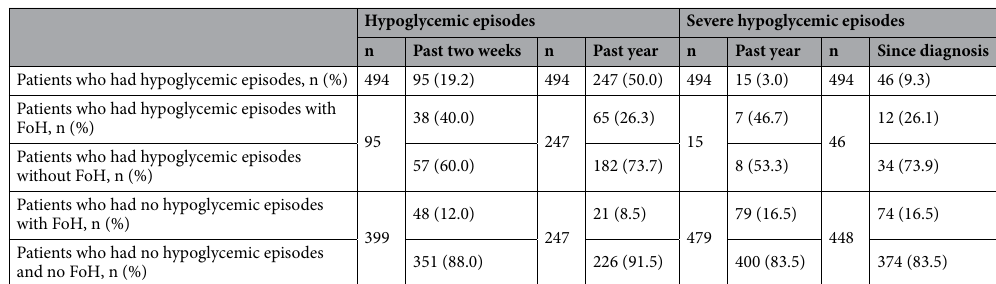
Table 3. The prevalence of hypoglycemia and fear of hypoglycemia in patients with type 2 diabetes. FoH, fear of hypoglycemia.